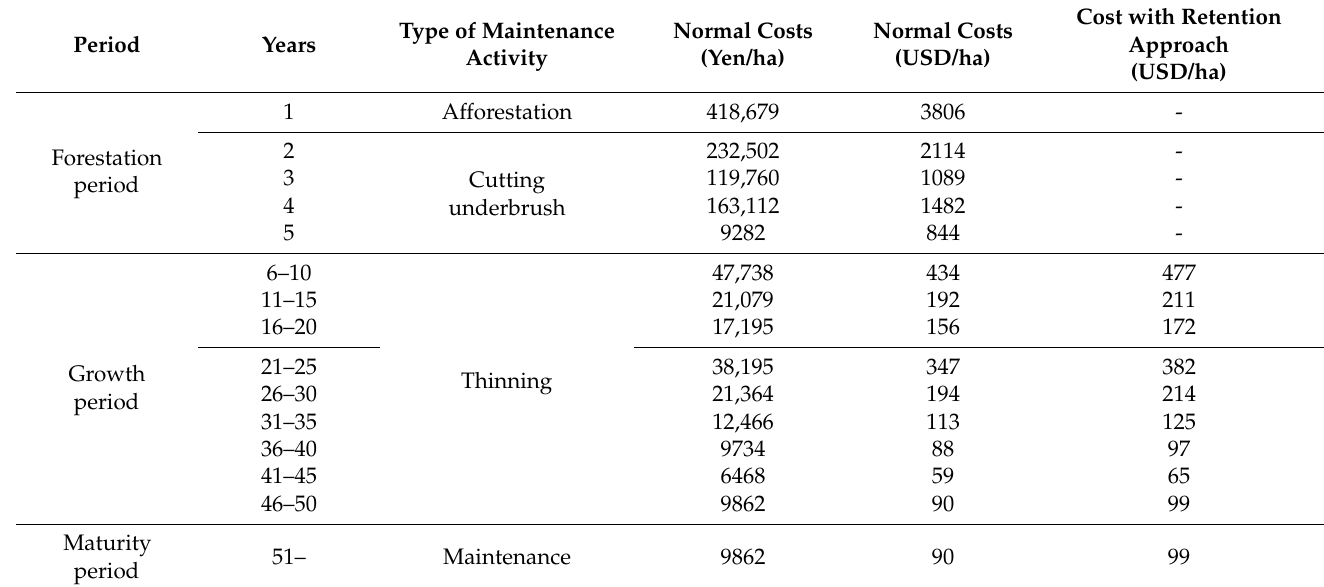
Table 1. Maintenance costs of production forests in Japan (Unit: ha). Source: